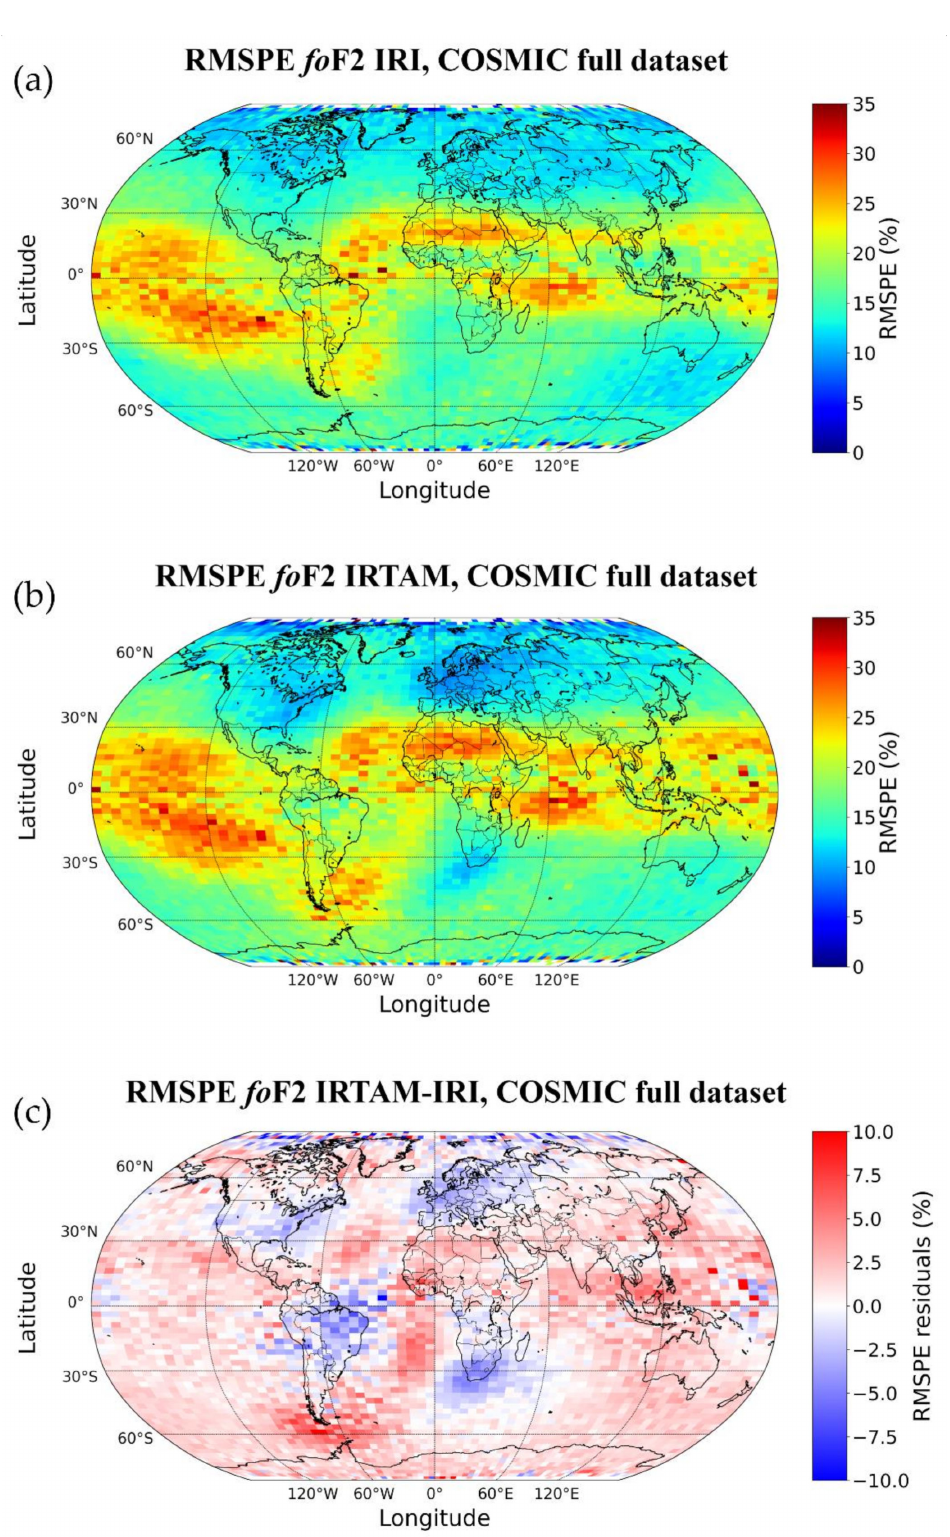
Figure 20. Maps of binned RMSPE values calculated between fo F2 values measured by COSMIC satellites and modeled by ( a ) IRI and ( b ) IRTAM, and ( c ) the corresponding map of differences. Data were binned as a function of the geographic latitude (2.5 ◦ -wide bins) and longitude (5 ◦ -wide